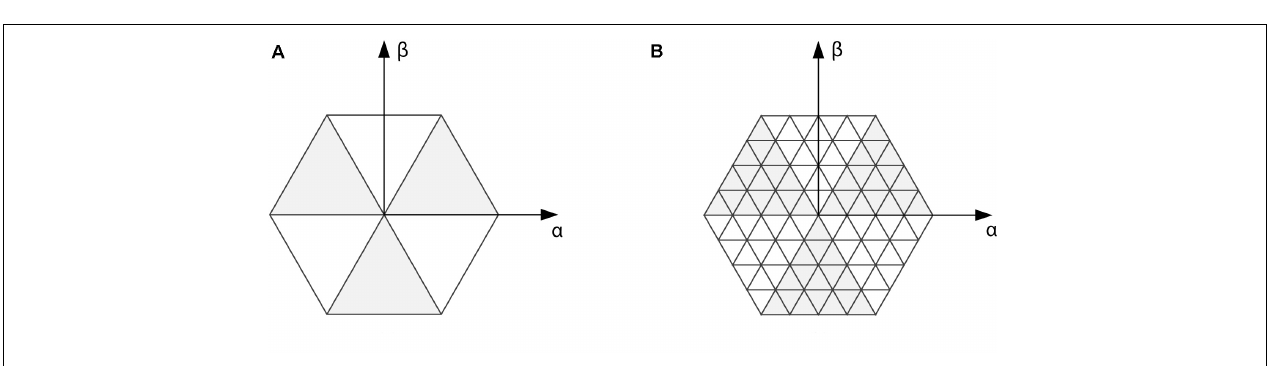
FIGURE 13 | Space vector representation for three-phase inverters: (A) two-level; (B)